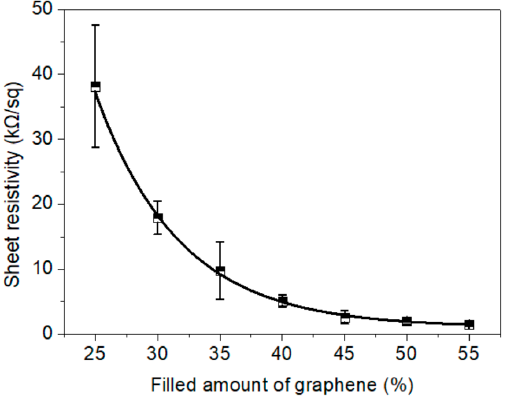
Figure 8. Sheet resistivity of the 16 g·m − 2 membranes with different amounts of graphene.